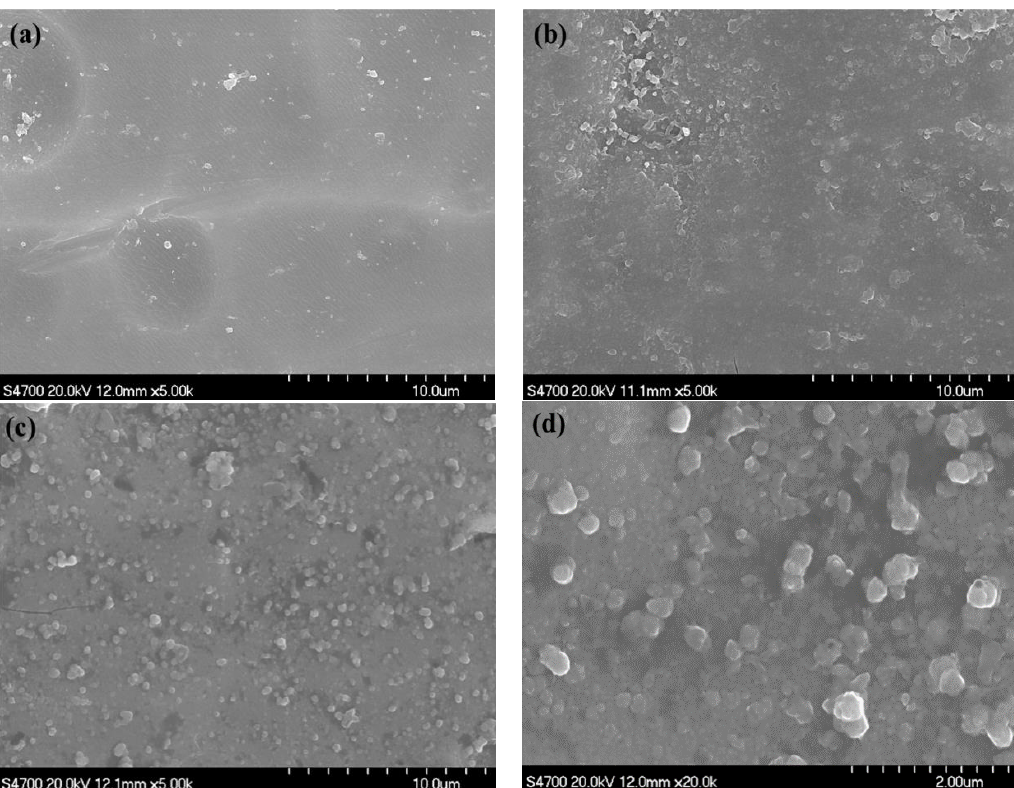
Figure 1. SEM images of conversion-coated 5052 aluminum alloy: ( a ) Al substrate; ( b ) conversion coating; ( c , d ) after FAS-17 modification.